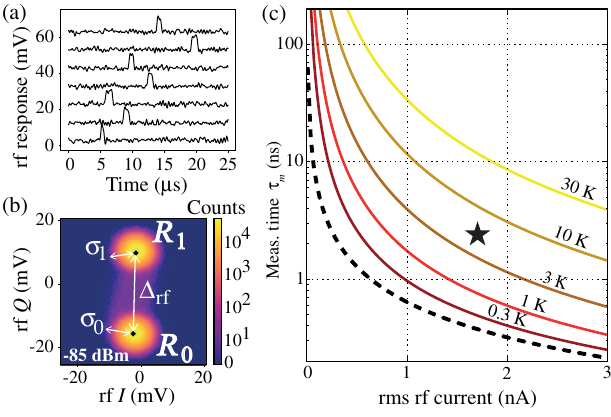
FIG. 2. High-sensitivity charge detection. (a) Examples of charge transition events of the third electron on the right donor dot ( D 2 ) detected by the change in rf SET response. (b) 2D histogram in I - Q space showing the bimodal Gaussian distribu- tion of many charge detection traces of the third electron on D 2 measured with − 85 dBm rf power reaching the device. The distribution shows two clear peaks centered around R 0 and R 1 (separated by Δ ) with standard deviations of noise σ 0 and σ 1 rf corresponding to the respective ON and OFF electron charge states on the donor quantum dot. (c) The theoretically optimal sensitivity, characterized by the measurement time τ , as a m function of the rms rf current through the rf SET. The black dashed line indicates the theoretical shot-noise limit. Solid curves show how τ increases with additional amplifier noise, with noise m temperature between 0.3 and 30 K. A star indicates approx- imately the sensitivity achieved in the present